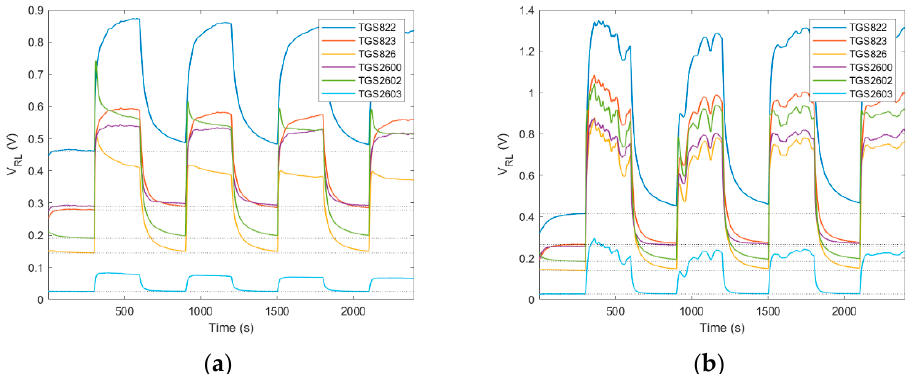
Figure 4. Raw sensor signals resulting from ‘ exposure-cleaning ’ operation repeated four times, preceded by the establishment of the initial baseline; ( a ) signals of most sensor approach the steady state during exposure to beehive air; ( b ) sensor signals do not attain steady state due to rapid fluctuations of the tested gas composition or obstruction of its access to sample probe. Dotted lines show the baseline of the first sensor signal as indicated by the initial exposure to clean air.